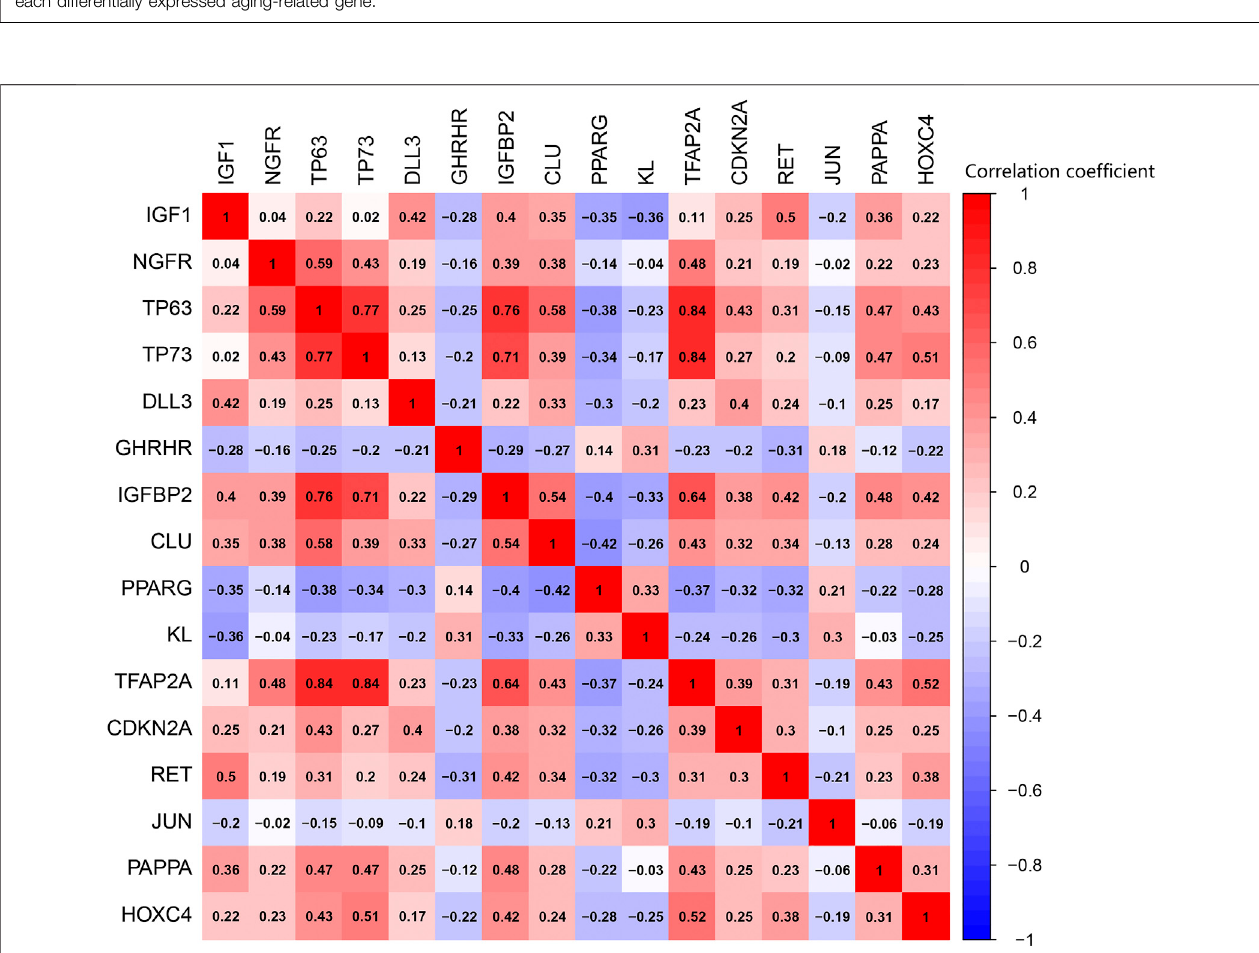
FIGURE 4 | Pearson correlation analysis of the 16 differentially expressed aging-related genes.